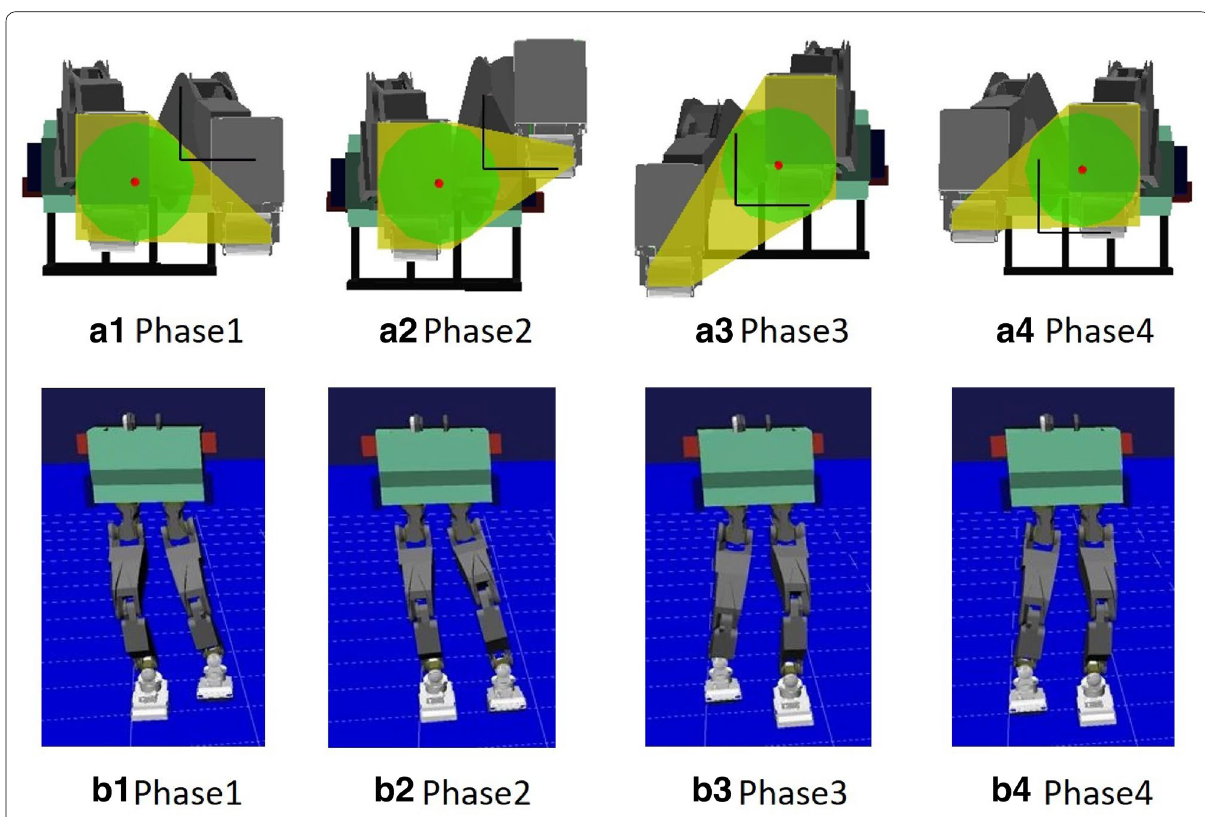
Fig. 5 Results of stability margin maximization ( a 1– a 4) and dynamics simulation ( b 1– b